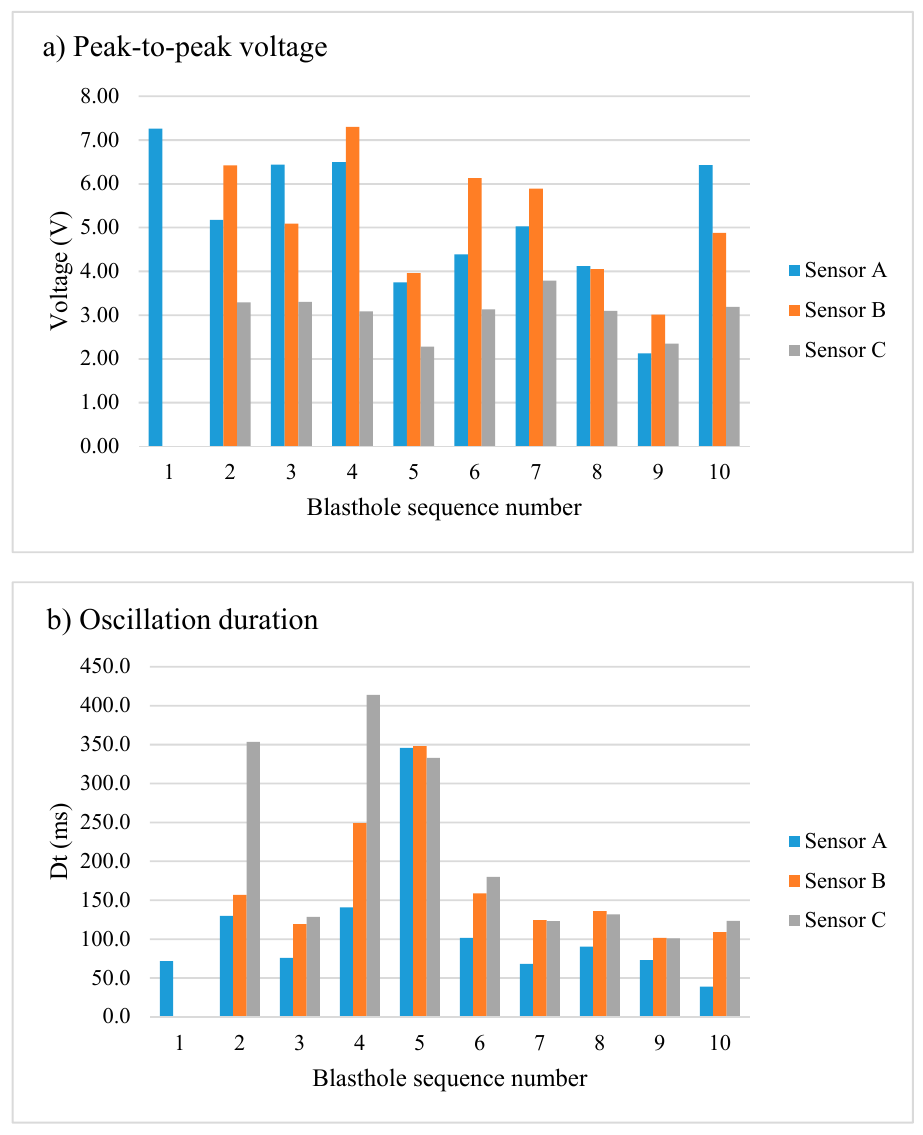
Figure 8. ( a ) Peak-to-peak recorded voltage for the blasthole sequence number. ( b ) Oscillation time for each blasthole sequence number; sensor C systematically measured lower peak voltages but for a longer duration of the oscillation.